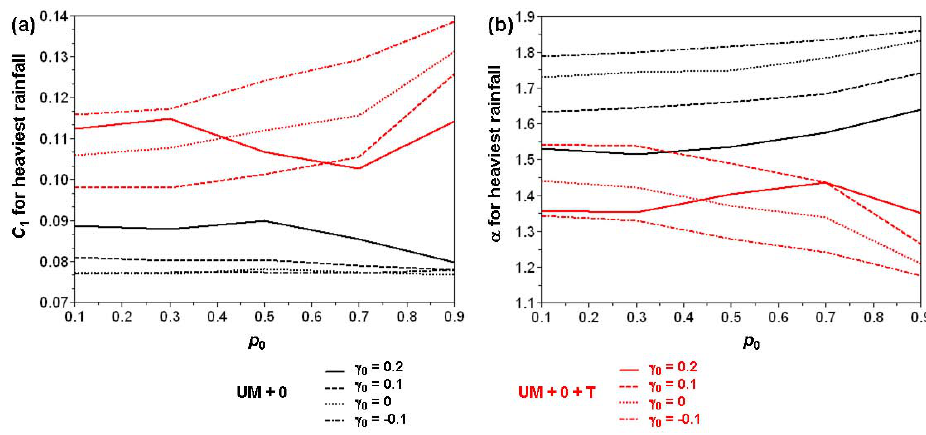
Fig. 9. Analysis of the sensitivity to γ 0 and p 0 : C 1 (a) and α (b) for the heaviest